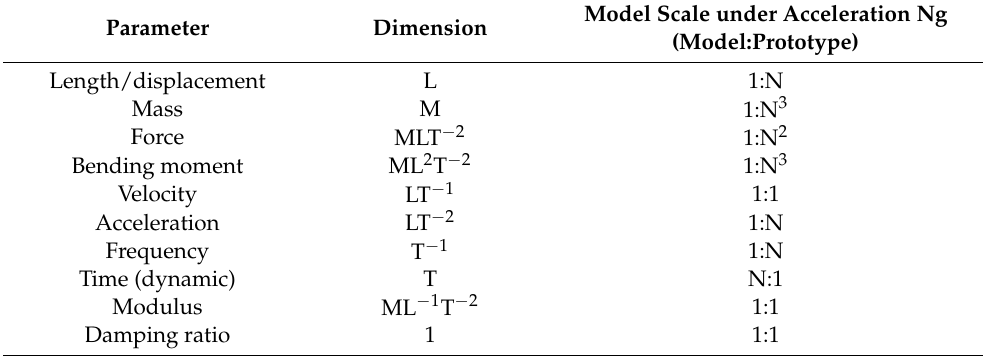
Table 1. Selected centrifuge scaling